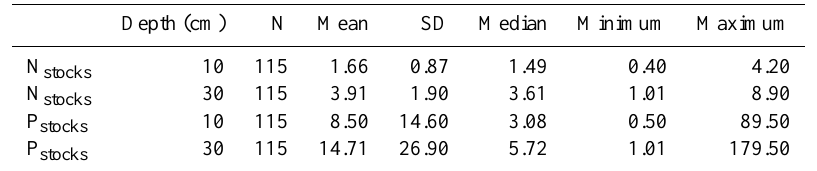
Table 4. Statistics of soil nitrogen (N stocks , express as Mgha − 1 ) and phosphorus (P stocks , kgha − 1 ) at 0–10 and 0–30cm soil depth layers for pasture soils included in the regional survey.